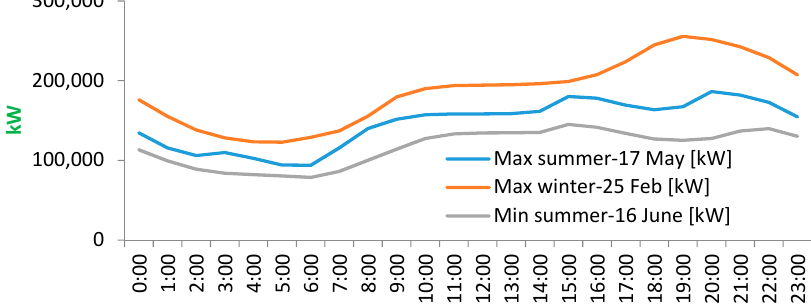
Figure 4. Active power load curves for characteristic days in Sarajevo Canton for 2018 [29].